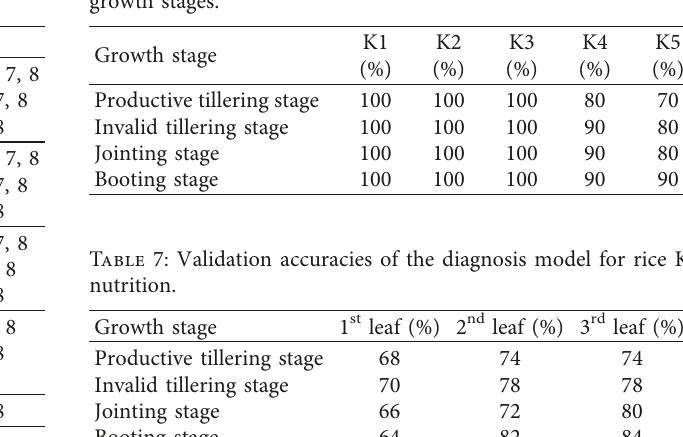
Table 4: Selected feature subset of the different leaf positions under K deficiency.